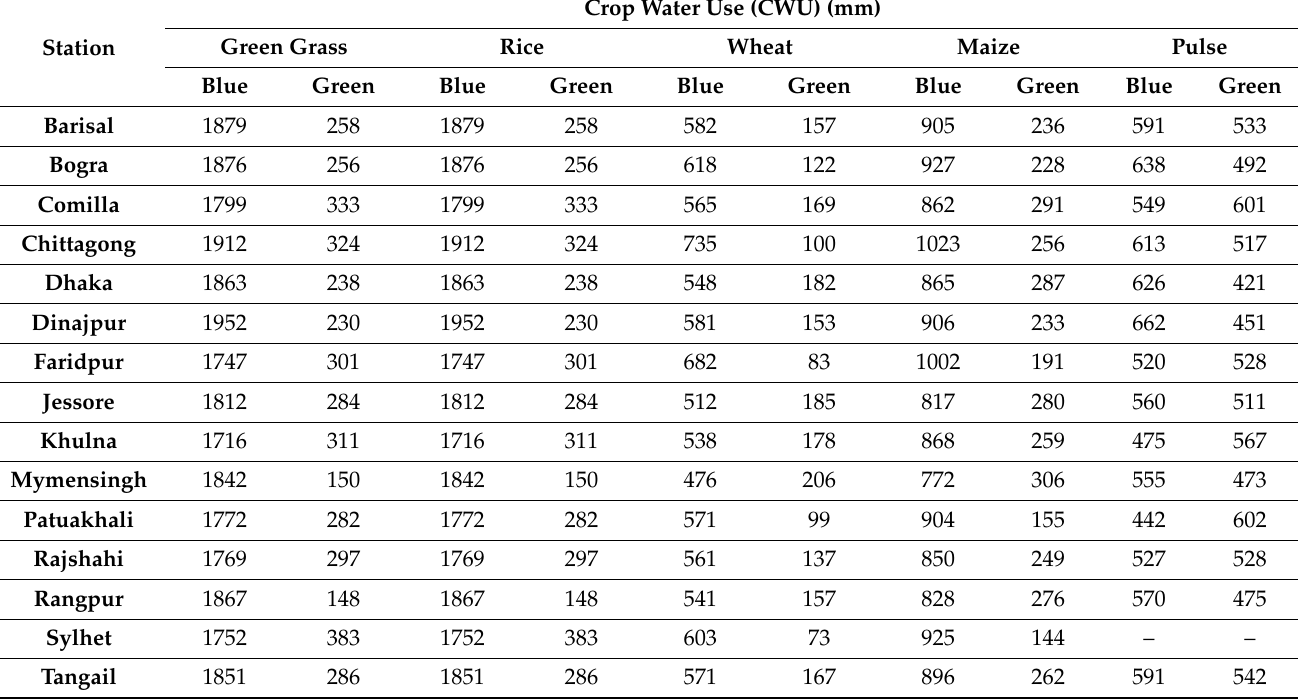
Table A1. Crop water use of the major crops for livestock feed in meteorological stations in